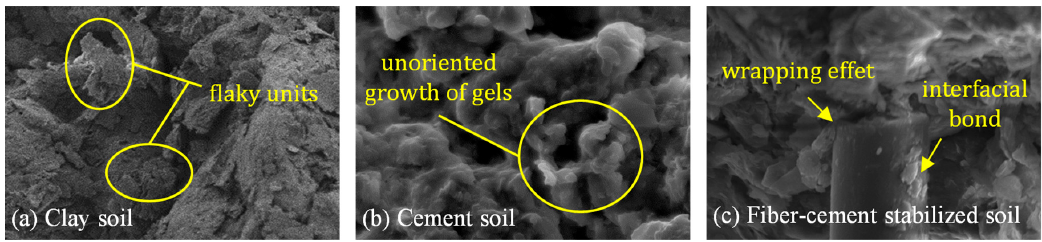
Figure 10. Typical microstructure scanning electron micrograph (SEM): ( a ) clay soil; ( b ) cement soil; ( c ) fiber-cement stabilized soil.